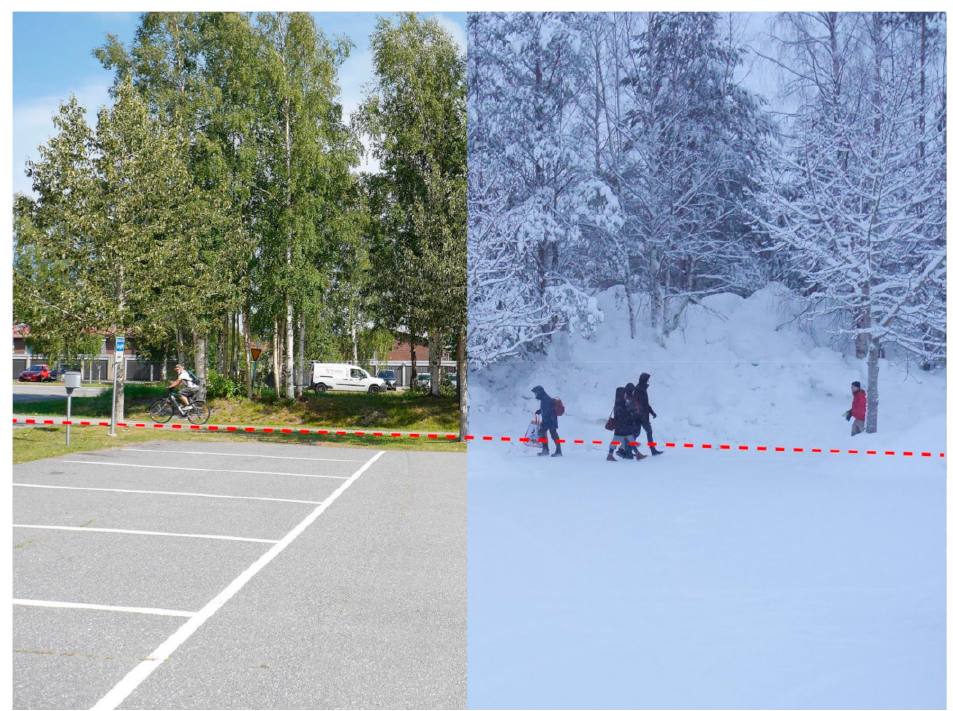
Figure 7. An illustration of how the image of the same area in summer (left) and winter (right) can change due to weather conditions (copyright: David